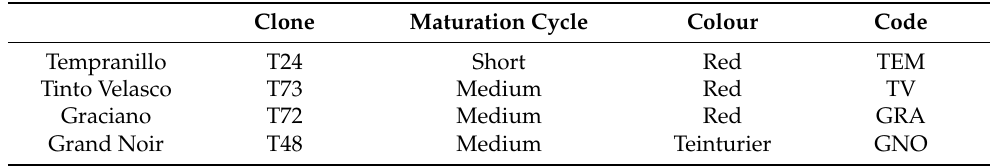
Table 1. Local ancient grapevine varieties studied. Cuttings were collected during the winter of 2020 from plants grown in the vineyard located in the Estación de Viticultura y Enología de Navarra (EVENA) (Navarra, Spain).